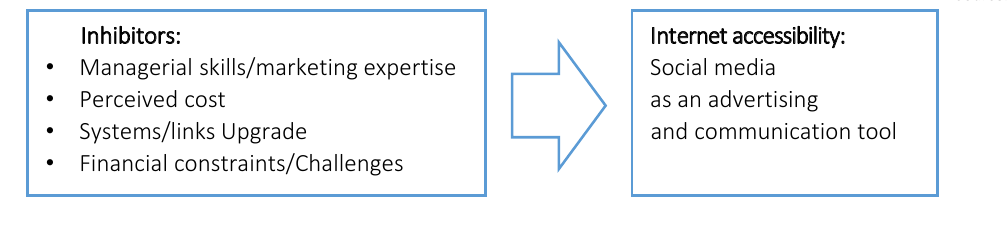
Figure 1. Conceptual framework.